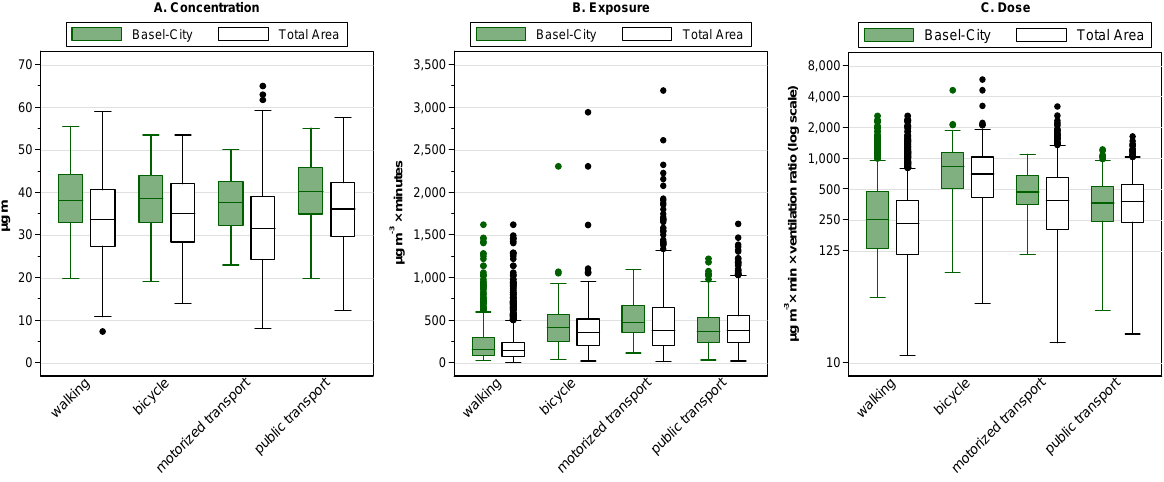
Figure 5. Box plots of in-traffic NO concentration ( A ); exposure ( B ); and dose ( C ) by 2 travel mode and study area using the PolluMap model. Estimates are based on commute legs: boxes represent 25th to 75th percentile, central line the median, bars outside the box represent the most extreme values within 1.5 × the inter quartile range of the nearer quartile, and circles are